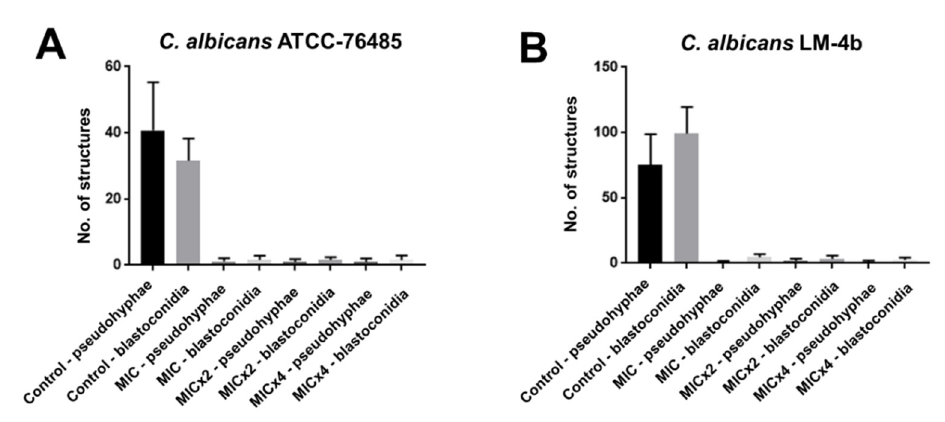
Figure 1. Growth of pseudo-hyphae and blastoconidia of ( A ) American Type Culture Collection (ATCC)-76485 and ( B ) LM-4b in groups treated (MIC, MIC × 2, MIC × 4) and not treated (negative control) with isoeugenol.